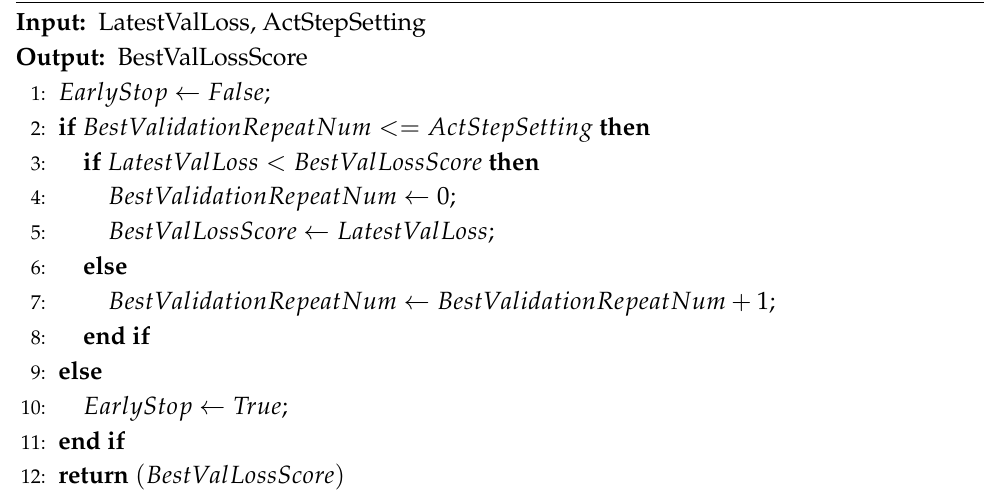
Algorithm 1 Validation Loss Tracking for Early Stop